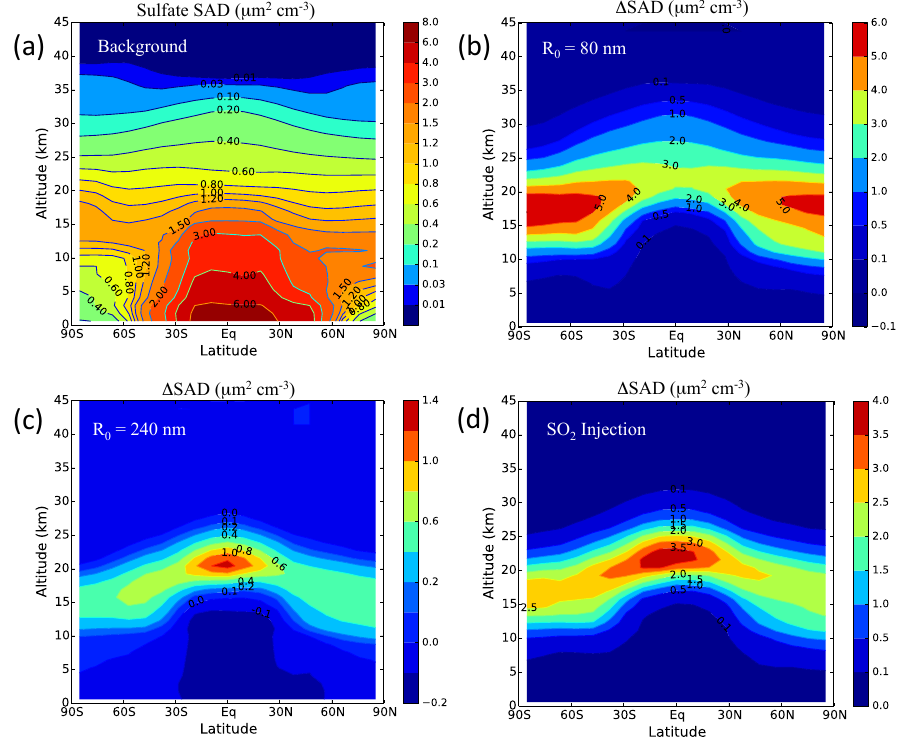
Figure 9. Calculated annual average sulfate surface area density (µm 2 cm − 3 ) of (a) sulfate particles without geoengineering, and surface area density increase (µm 2 cm − 3 ) with geoengineering injections of (b) 1Tgyr − 1 of 80nm alumina monomers and (c) 1Tgyr − 1 of 240nm alumina monomers. Panel (d) shows sulfate aerosol surface area density increase (µm 2 cm − 3 ) with 1Tgyr − 1 of SO 2 injection.